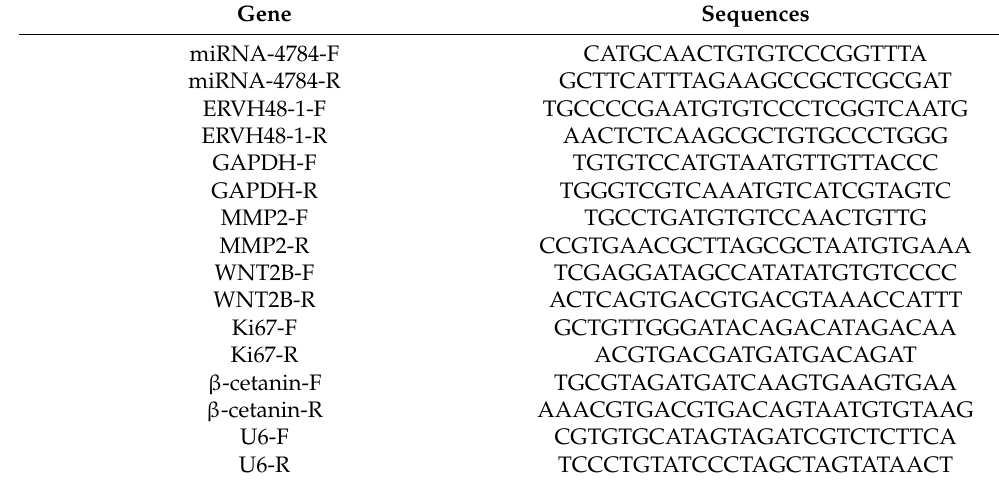
Table 1. Gene primer